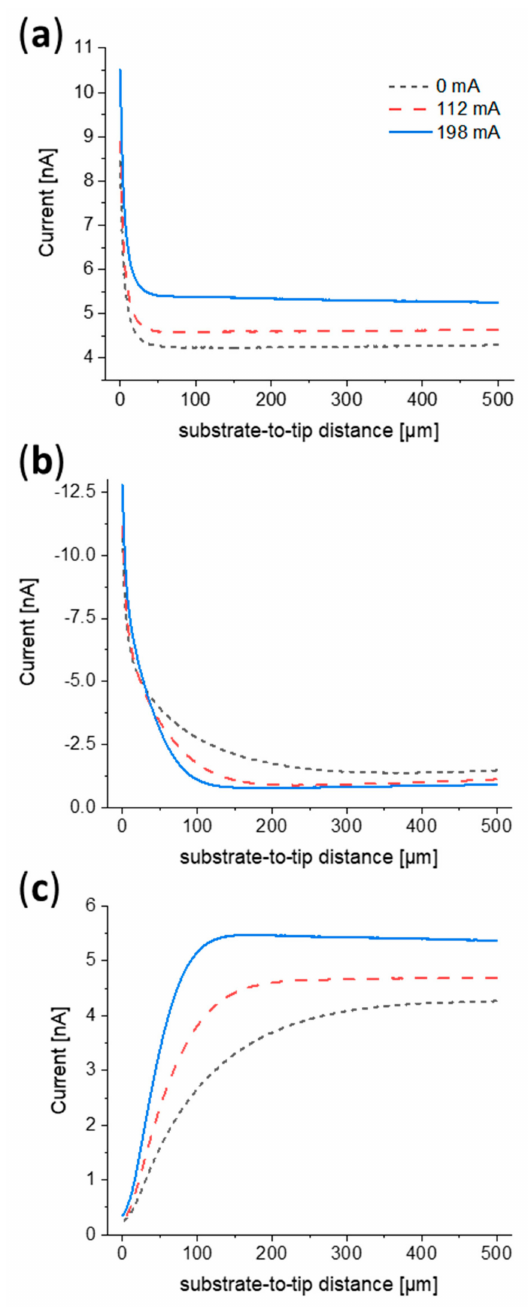
Figure 3. Probe approach curves (PACs) with a 25 µ m probe towards a flattened Pt wire in di ff erent scanning electrochemical microscopy (SECM) operation modes for di ff erent heating currents flowing through the wire. Measurements were carried out in 1.5 mM FcMeOH and 200 mM KNO 3 . ( a ) Feedback mode: E (probe) = 0.5 V. ( b ) SG / TC mode: E (probe) = 0 V, E (wire) = 0.5 V. ( c ) Competition mode: E (probe) = E (wire) = 0.5